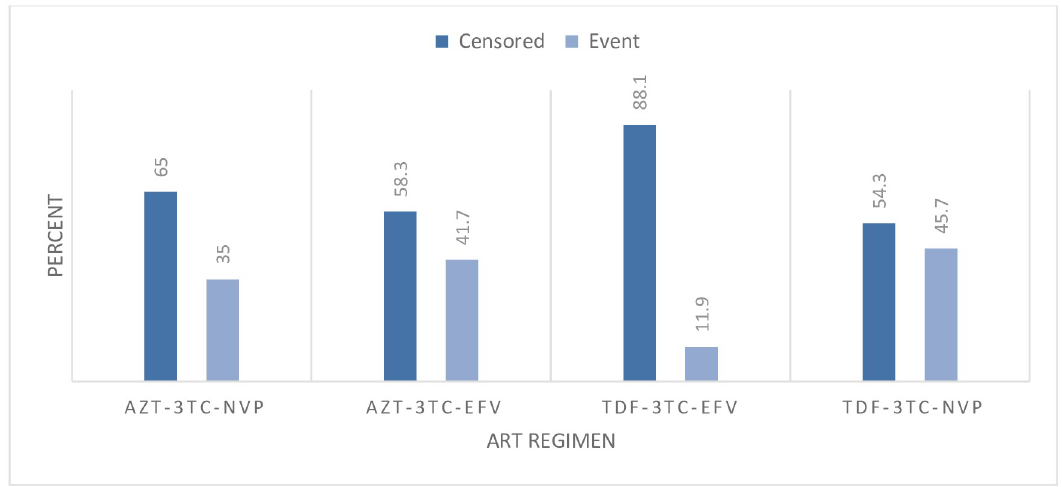
Fig 3. Distribution of ADRs by initial ART regimen type among adult HIV positive patients on ART in public health facilities of Arba Minch town, southern Ethiopia, 2020.